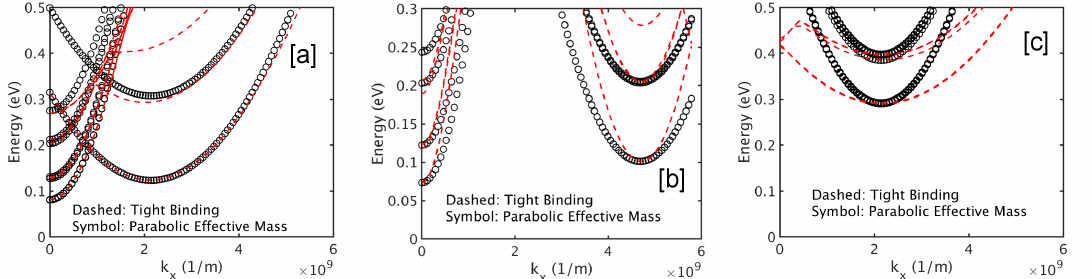
Figure 2. Comparison of the electronic band structure calculated within the parabolic effective mass approximation and tight binding method for nanowires oriented along: ( a ) [100] direction; ( b ) [110] direction; and ( c ) [111] direction. Good agreement in terms of the subband minima and curvature at the minima are obtained for all the three